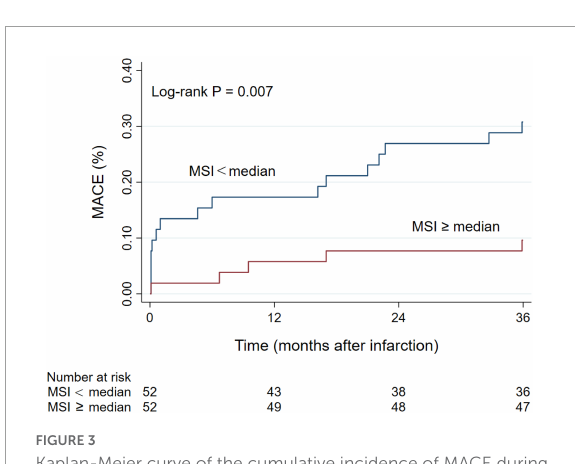
FIGURE3 Kaplan-Meier curve of the cumulative incidence of MACE during 3-year follow-up. MACE, major adverse cardiac events; MSI, myocardial salvage index.